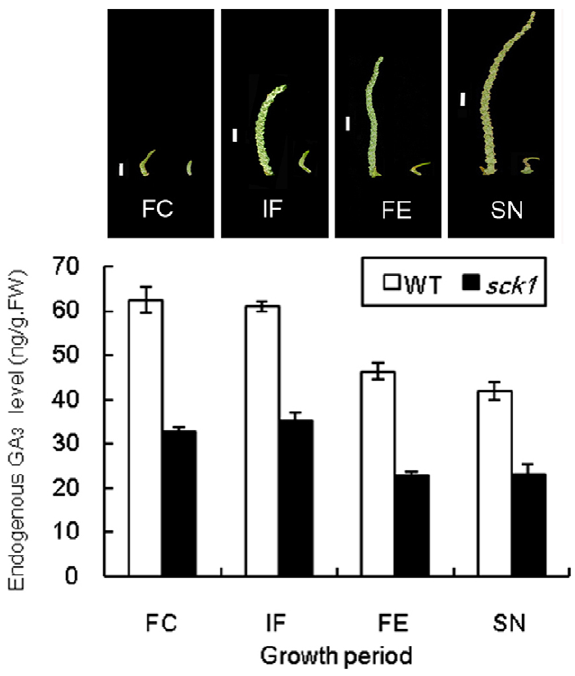
Figure 2. The phenotype of WT and sck1 and dynamic patterns of GA 3 content during the catkin development. Formation of the primordium of the floral cluster (FC), the individual floret (IF), the floral envelope (FE) and the stamen (SN). The catkins of sck1 became yellow in FE and became curved in SN. Catkins were gathered in the four periods, and the endogenous GA 3 were determined by LC/MS. Data are means ( 6 SE, n=3).